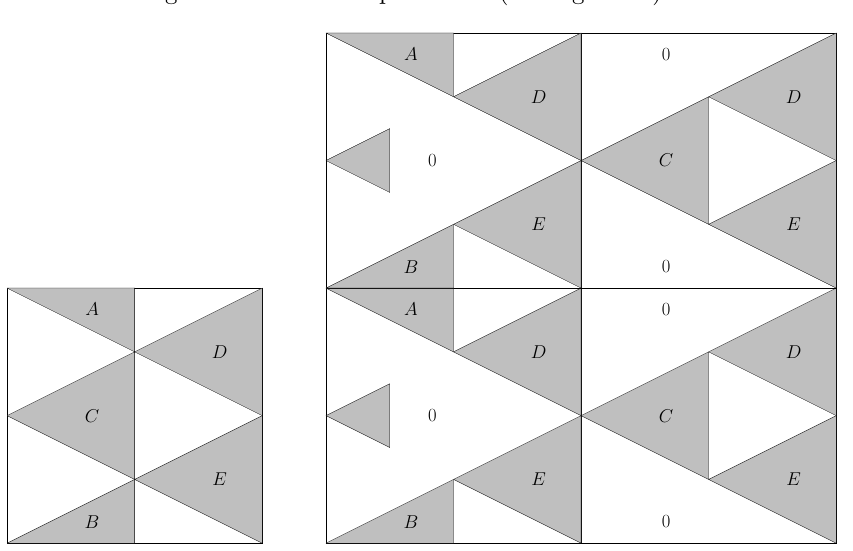
Figure 18: When we take into account the null parts, the pattern at n looks very similar to the one at n − 1. The fractal structure is